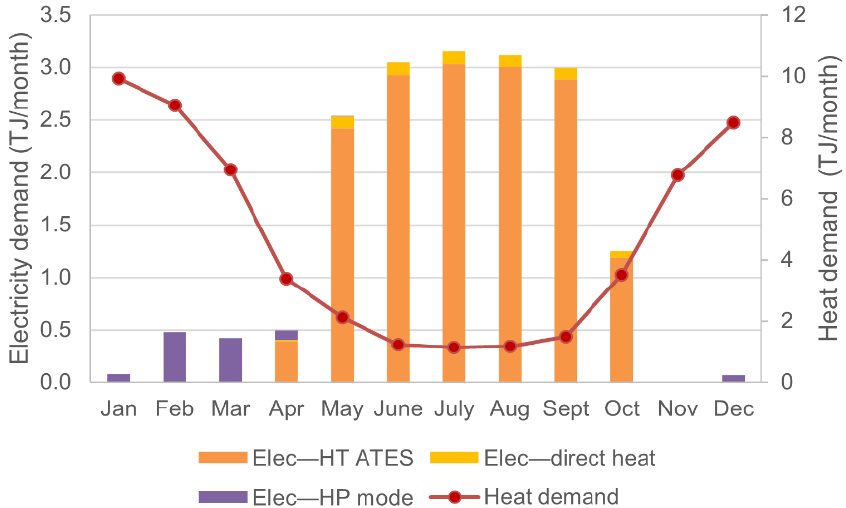
Figure 5. Electricity demand (left axis) for heat production is shown together with the heat demand (right axis) for the 65|30|1.5 scenario, which is the scenario with the highest utilization of the HT-ATES feeds heat pump mode. The electricity demand is divided into heat production for the HT-ATES (Elec—HT-ATES), the direct production of heat for the MES (Elec—direct heat) and the electricity for the HT-ATES feeds HP mode (Elec—HP